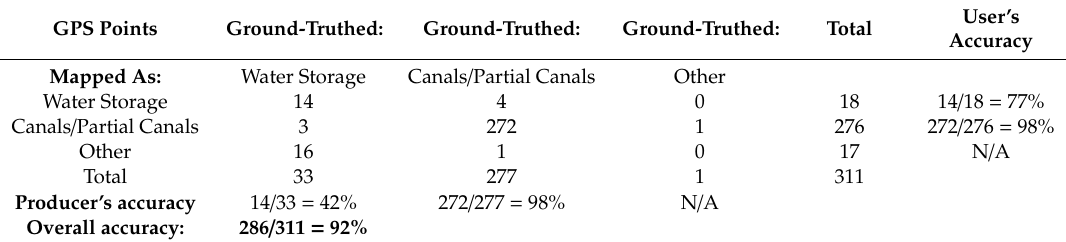
Table 1. Accuracy matrix of canals and storage points, when ground-truthed by GPS (Global Positioning